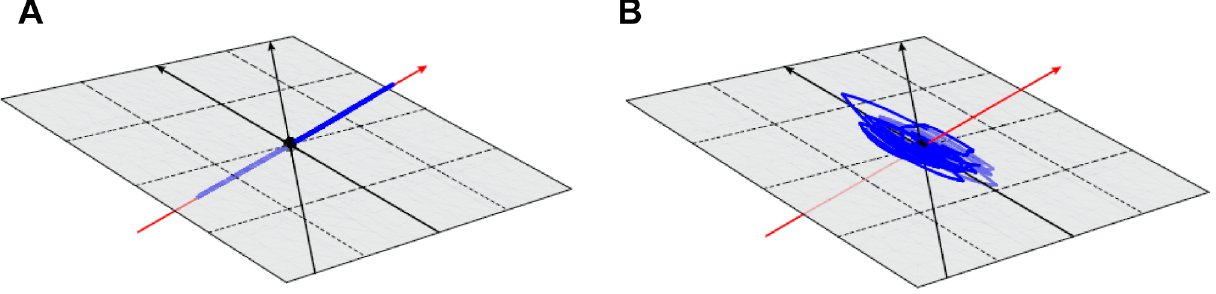
Figure 4. Effect of the direction of perturbation on early warning signals. Predator death rate is fixed at m P =0.55 (close to the catastrophe), and the death rate of either the juveniles or the adults is perturbed using white noise with standard deviation s =0.005. System trajectories are plotted in blue for 60 time units. The dominant eigenvector is indicated by the red arrow, and the second and third eigenvector are indicated by the black arrows. ( A ) When the juvenile death rate is perturbed, the system responds only in the direction of the dominant eigenvector, resulting in an early warning signal that is only apparent in juvenile population fluctuations. ( B ) When the adult death rate is perturbed, the system responds in the direction of the surface spanned by the second and third eigenvector (indicated in grey), resulting in damped oscillations and absence of early warning. For other model parameters see Figure 1. For an animated rotation of these 3D figures, and for direction and scaling of axis see Movie S1 and S2.